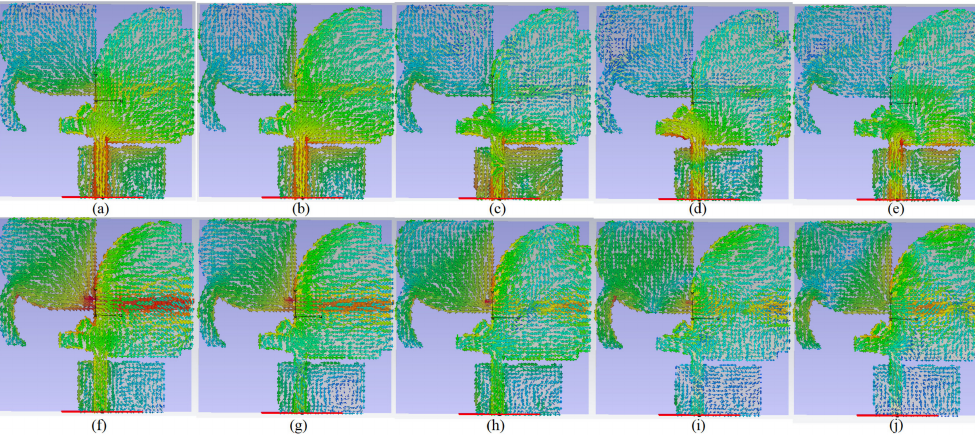
Figure 8. Distribution of the SCD after Ant 1 and Ant 2 were combined at: ( a , f ) 3.8 GHz, ( b , g ) 5.4 GHz, ( c , h ) 8 GHz, ( d , i ) 15 GHz), and ( e , j ) 28